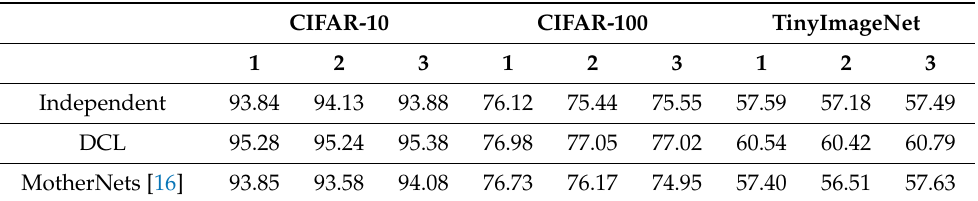
Table 1. A comparison between independent training, MotherNets, and DCL between models on CIFAR-10, CIFAR-100, and